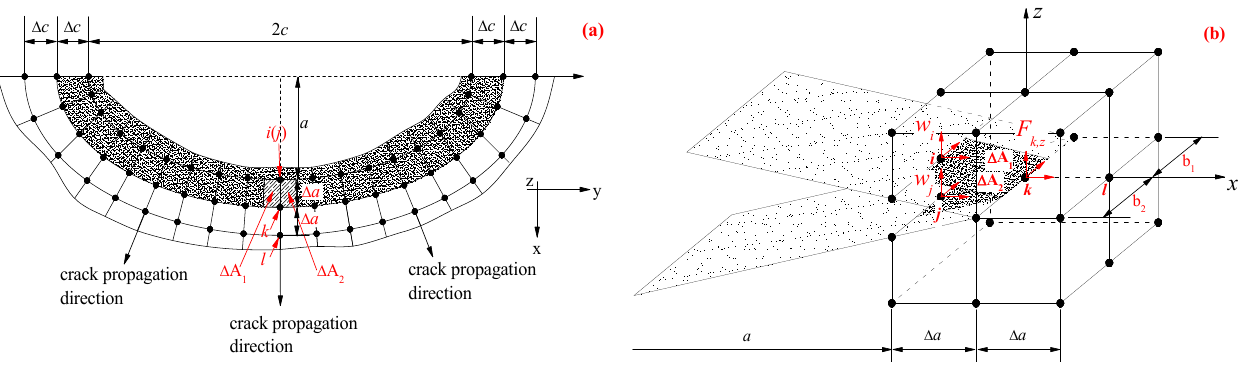
Figure 9. Schematic diagram of calculating strain energy release rate of surface crack by virtual crack closure technique: ( a ) Propagation section of semi-elliptical surface crack, ( b ) sketch map of the nodal force in front of the crack propagation and the opening displacements at the end of the crack propagation.(where 2c and a are the width and depth of the surface crack, respectively; ∆ a and ∆ c are the virtual crack growth increment in the depth and width directions, respectively; F k , z is the nodal force of the element in front of the crack propagation in the normal direction of the crack propagation surface; w i and w j are the opening displacements of node i and node j in the normal direction of the crack growth surface, respectively; ∆ A 1 and ∆ A 2 are the area of the opening crack during the virtual crack propagation, b 1 and b 2 are the width of elements on both sides of the crack propagation direction, respectively.).